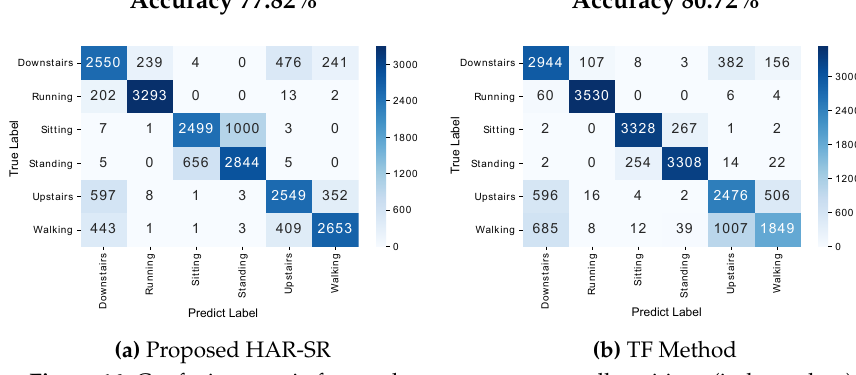
Figure 16. Confusion matrix for accelerometer sensor at all positions